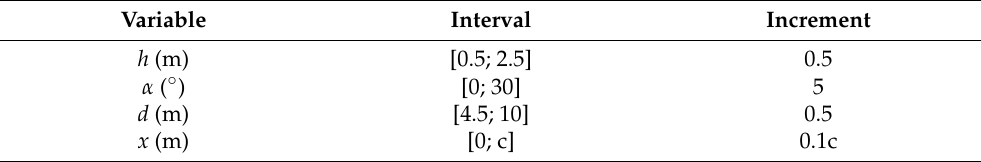
Table 2. Considered values of the design